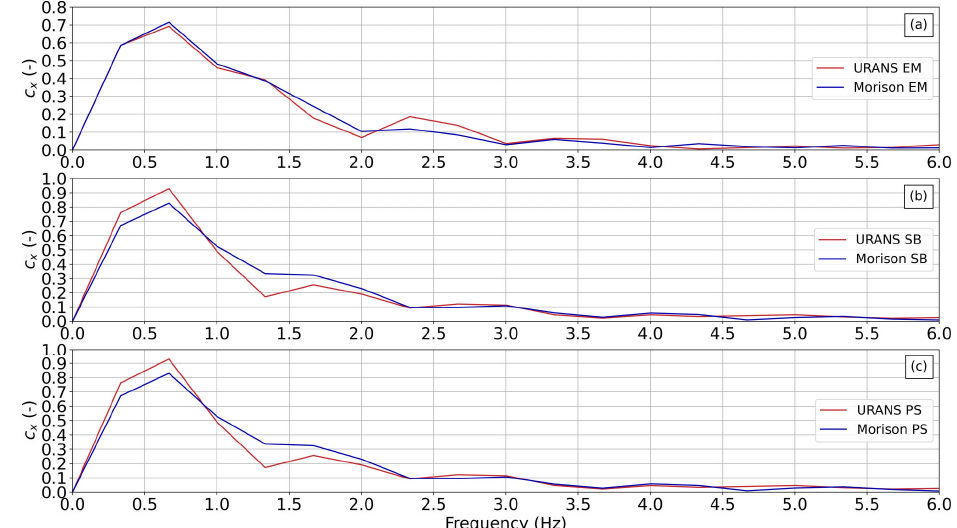
Figure 19. Frequency spectra of load coefficient c x in scenario 2 for the large ‐ diameter upstream cylinder ( a ), for the large ‐ diameter downstream starboard cylinder ( b ), and for the large ‐ diameter downstream portside cylinder ( c ).